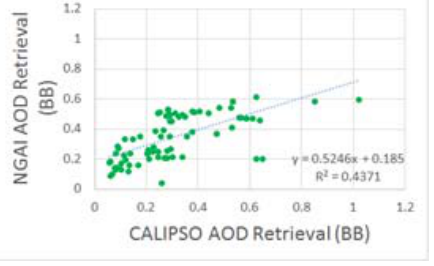
Figure 3. The comparison between CALIPSO and NGAI for fractional AOD 0.53 μ m and AOD 0.55 μ m of BB